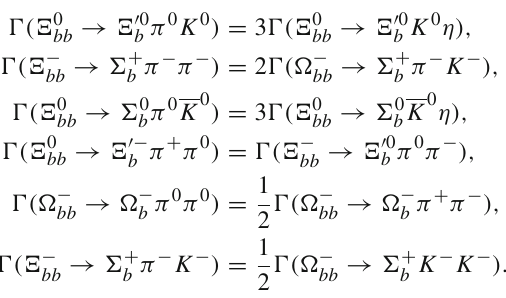
→ (cid:6) + π 0 ), D − s bb b 0 → (cid:2) (cid:4)− D K + ), 2 (cid:15)((cid:2) 0 bb b